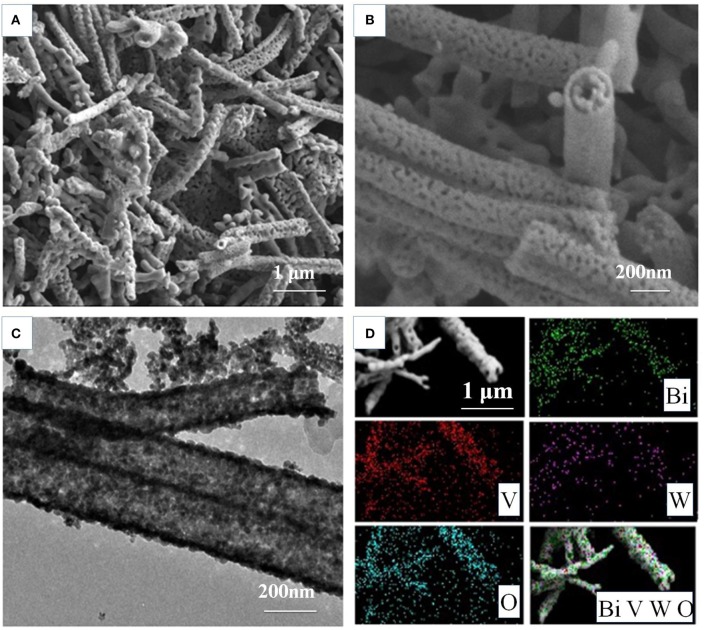
Morphology characterizationofthe BiV0.97W0.03O4 nanotubes: (A,B) SEM images; (C) the corresponding TEM images; (D) the elemental mapping Bi, V, O, and W, respectively.